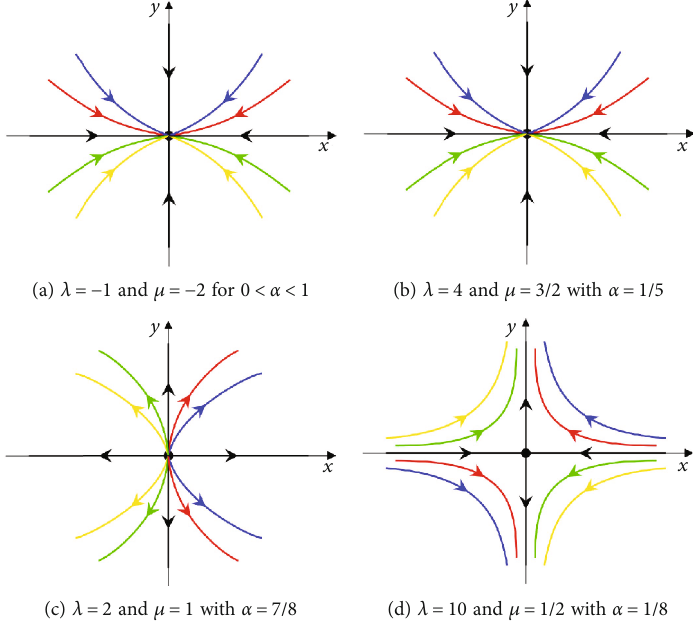
Figure 3: The phase portraits of system (8) for λ ≠ μ and λμ > 0 at di ff erent α .